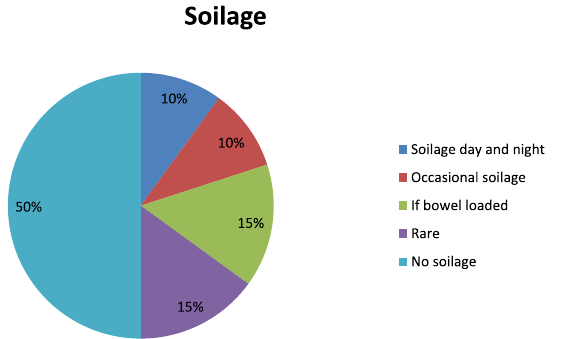
Fig. 1 Soilage rate after TEPT